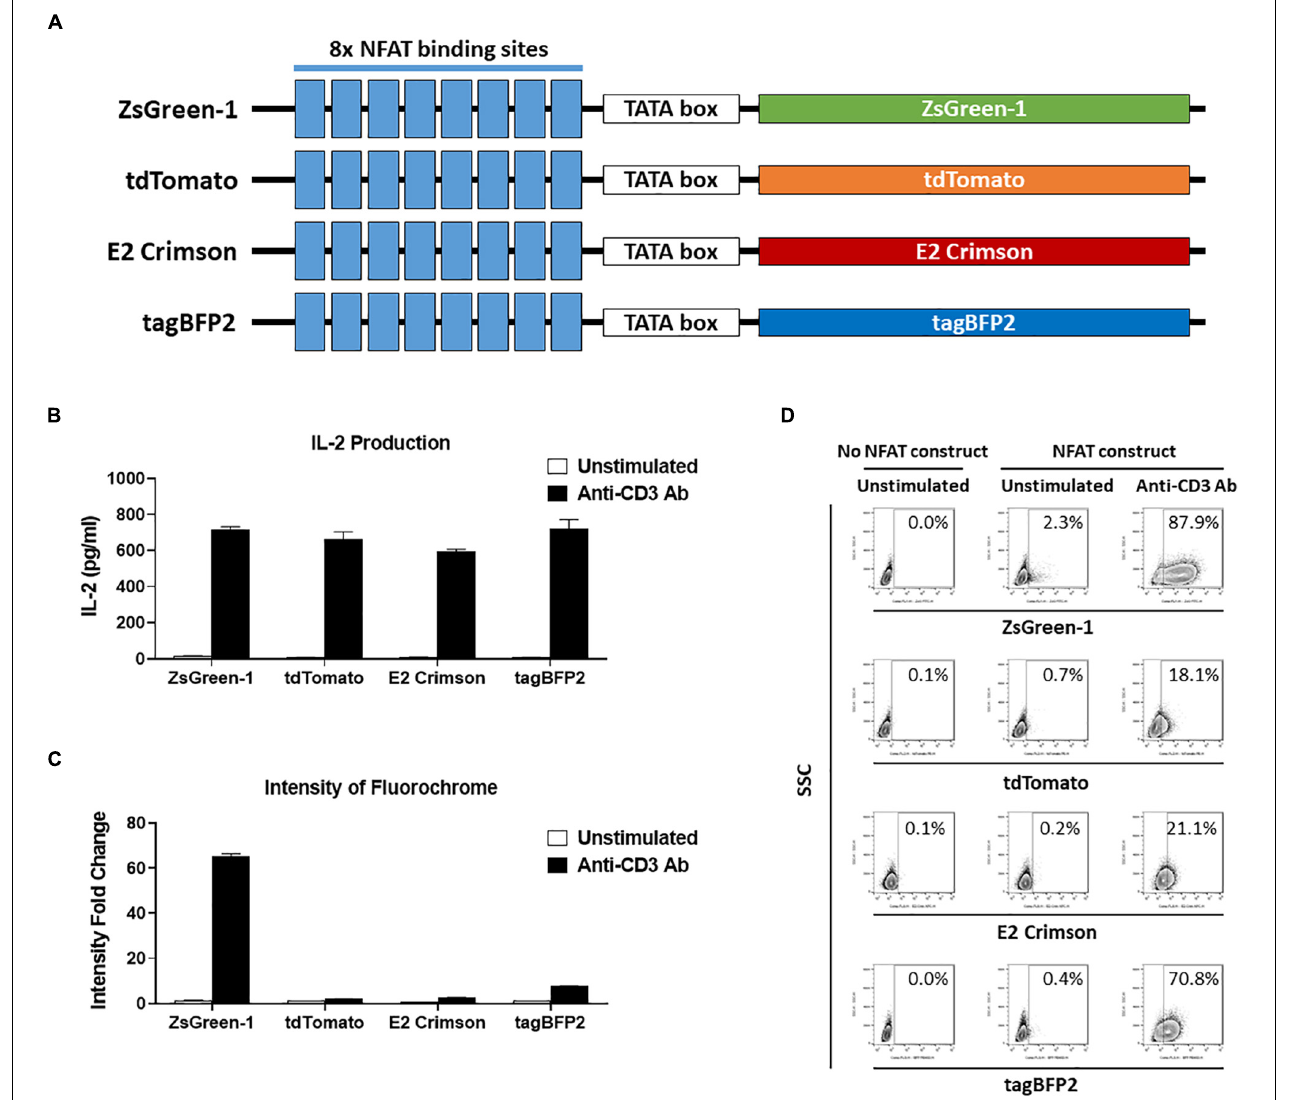
FIGURE 3 | Comparison of reporter fluorochromes. (A) Schematic showing the constructs that contained one of four potential fluorescent reporter genes. All constructs contain eight repeats of the NFAT binding site followed by a TATA-box. (B–D) 1E6 TCR 5KC T-hybridoma cells transduced with an NFAT-reporter construct containing each fluorescent reporter protein gene were cultured with or without anti-CD3 antibody overnight in the presence of K562 cells expressing HLA-A2. Values in panels (B) and (C) represent mean ± SEM from experiments performed in duplicate. (B) IL-2 production in culture supernatant was measured by ELISA. (C) Cells harvested from each culture condition were assessed on flow cytometer with 405, 488, and 633 nm laser beams. Fluorescent intensity of 5KC T-hybridomas, selected by the gating strategy shown in Supplementary Figure S1 , was determined. Fold change in mean fluorescent intensity of 5KC T-hybridomas transduced with an NFAT-reporter construct containing each fluorochrome over 5KC T-hybridomas without an NFAT-reporter construct is shown. (D) Representative flow cytometry contour plots showing proportions of stimulated and unstimulated fluorescent cells, each expressing a different fluorescent reporter protein. Cells without reporter construct are included to show baseline fluorescent intensity that was used to establish gate placement of fluorescence-positive cells. All results are representative of three independent